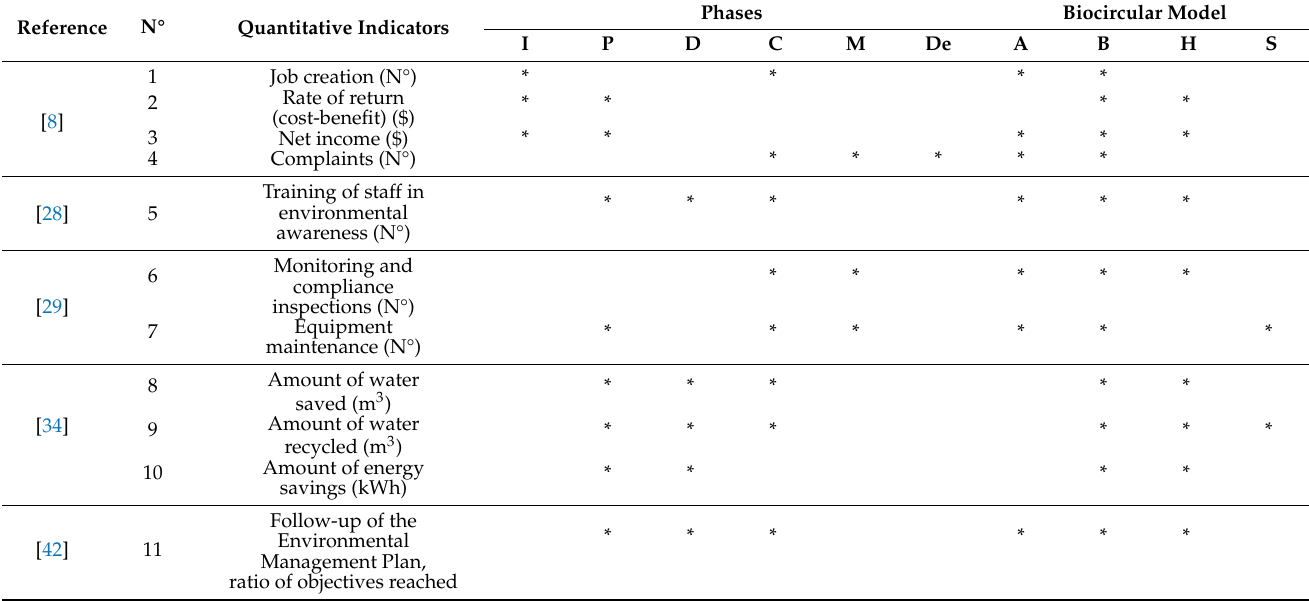
Table 3. Quantitative Indicators evaluated by the Biocircular